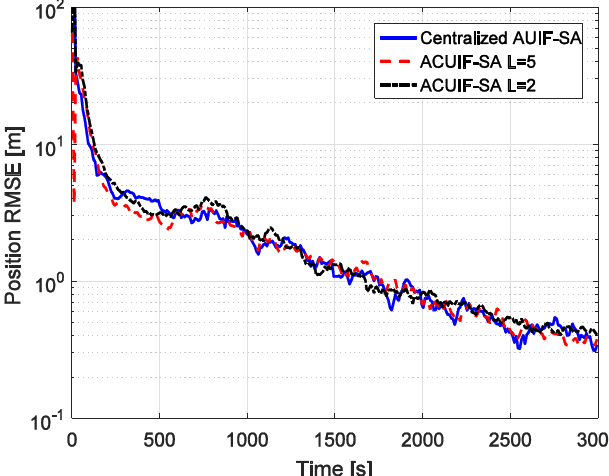
Sensors 2019 , 19 , x FOR PEER REVIEW Figure 3. The position RMSE for different methods over time in case 1. Figure 4. The position RMSE for di ff erent methods over time in case 1.